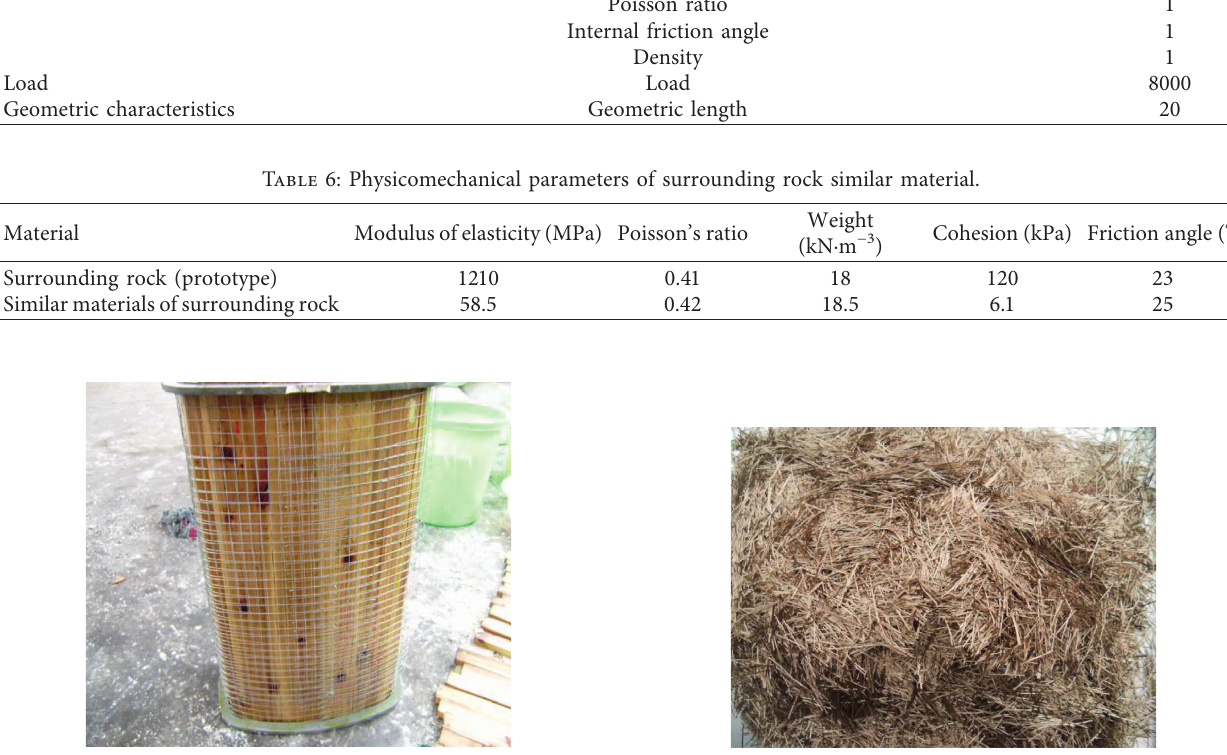
Figure 3: Double-wire mesh for simulation. Figure 4: Basalt fiber for